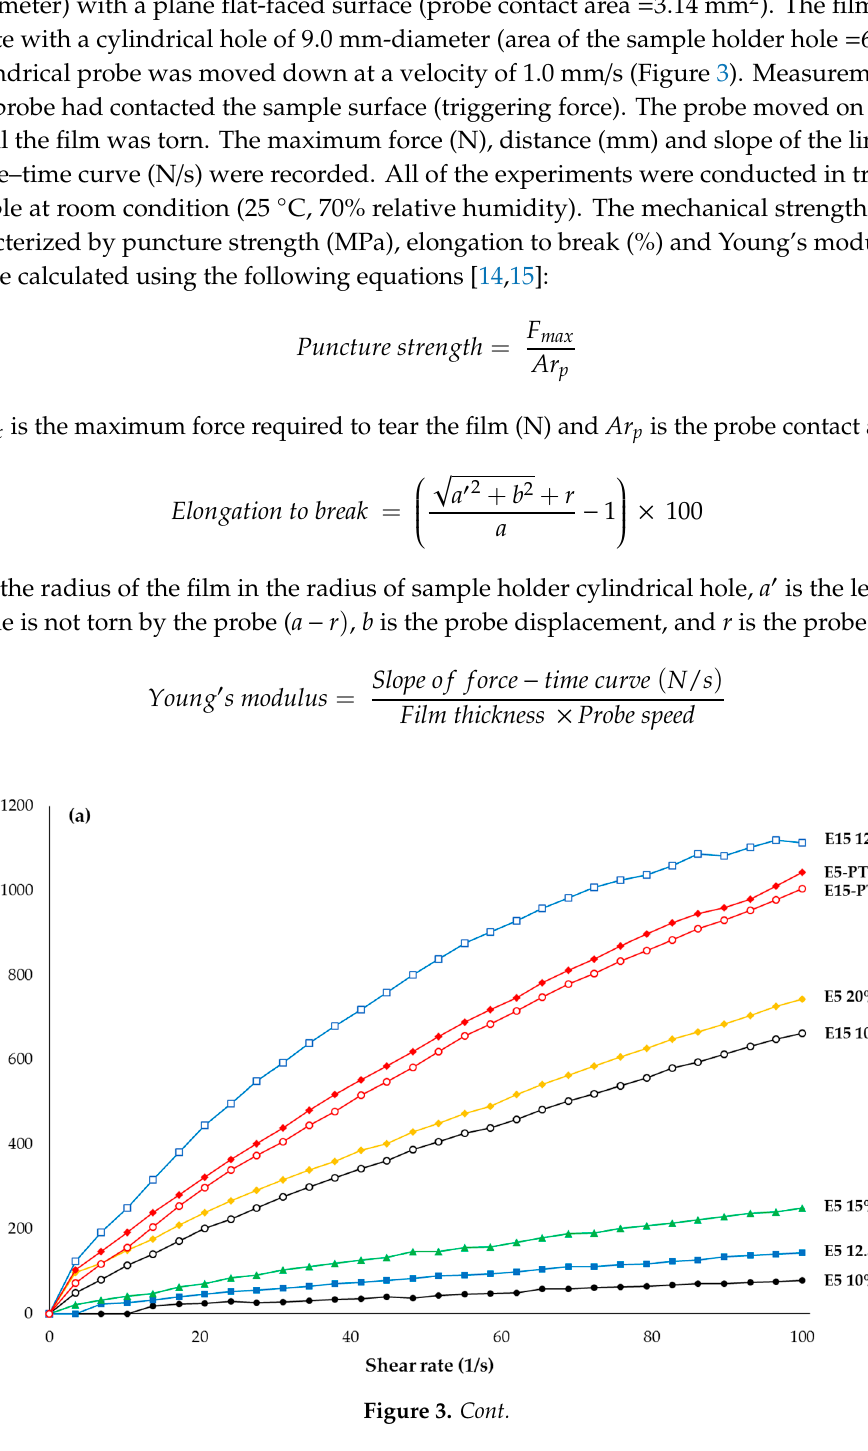
Figure 3. Rheological behaviors of hydroxypropyl methylcellulose (HPMC) E5 and HPMC E15 at different concentrations: ( a ) stress versus shear rate; ( b ) viscosity versus shear rate and fitting power ‐ law model. 2.4.4. In Vitro Disintegration Time Study The disintegration test method used in this study was modified from Preis et al. (2014) [16]. The printed ODF was clamped between the sample holder and the magnetic clip (attached to the bottom side of the film). The magnetic clip had a weight of 3 g (0.03 N) that represented the approximate minimal force applied by the human tongue. Then, the attached film was half ‐ immersed (50%) in 70 mL of simulated salivary fluid pH 6.8, which was prepared according to Marques et al. (2011) [17], at 37 ± 0.5 °C. The time required for the film to break and the magnetic clip to drop down was recorded